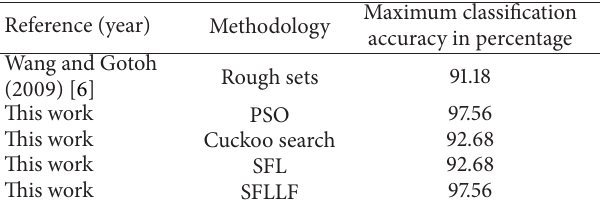
Table 13: Comparison of classification accuracy with other methods for